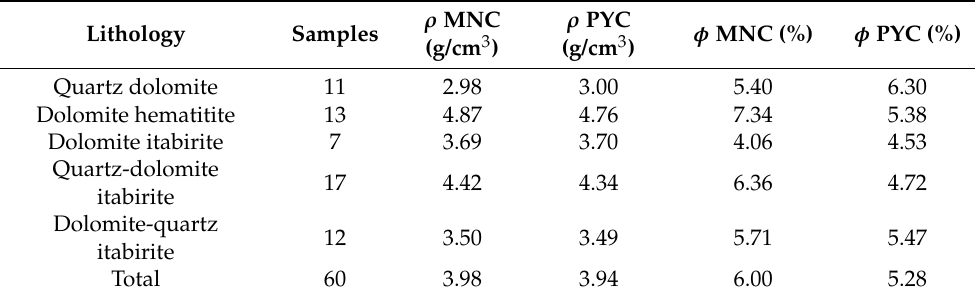
Table 4. Average mineral density ( ρ ) and porosity ( φ ) by lithology and measurement method— subgroup 3—unweathered (carbonate)